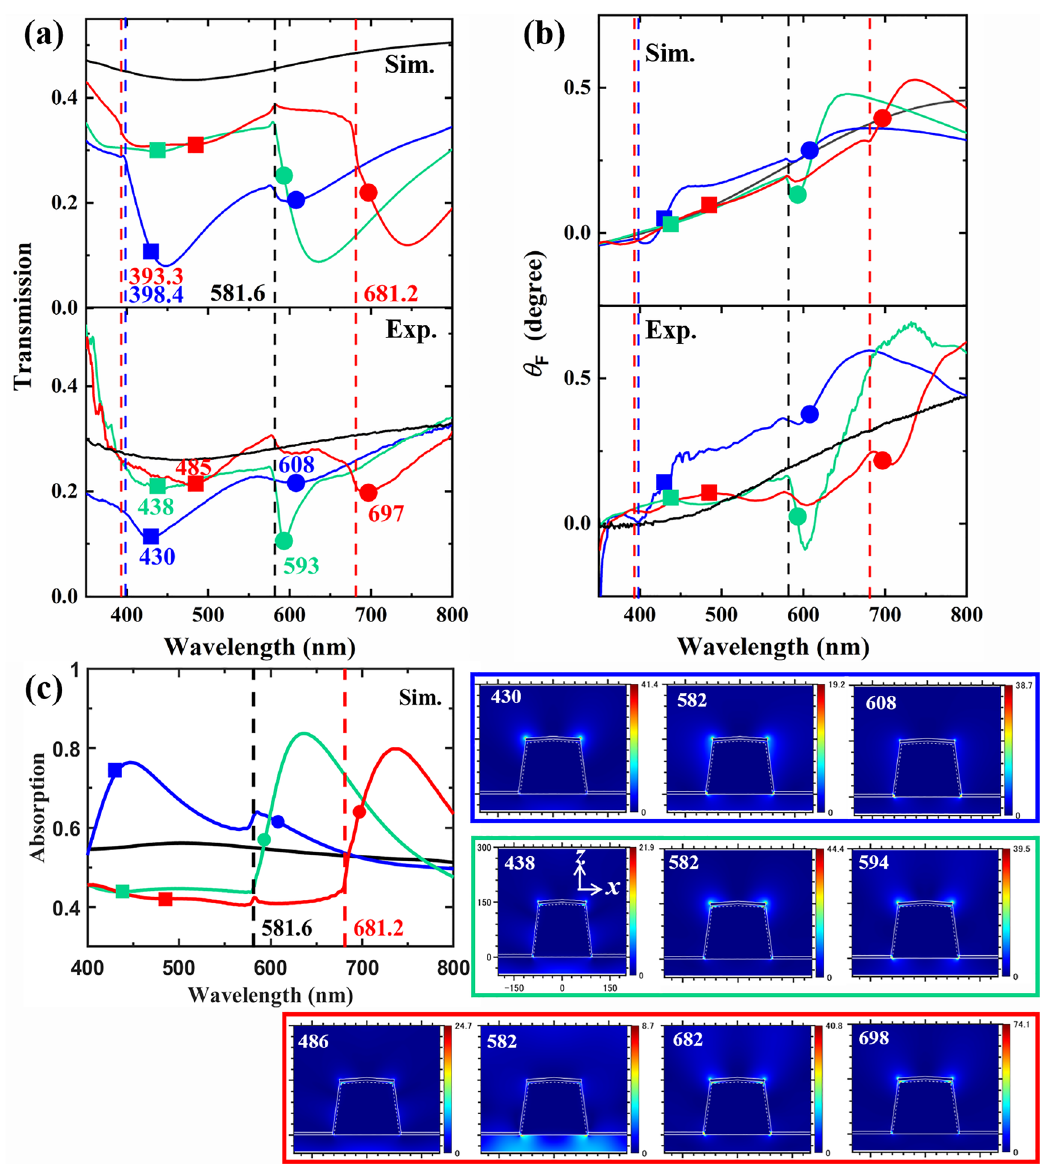
Figure 4: Calculated (upper panel, Sim.) and experimental (lower panel, Exp.) spectra of (a) optical transmissionand (b) Faraday rotation (FR) angle θ F of the Al nanoparticle (NP) array with a = 460 nm and 7.5 nm Fe fi lm on the top at θ 0 = 0 ° with different superstrates.